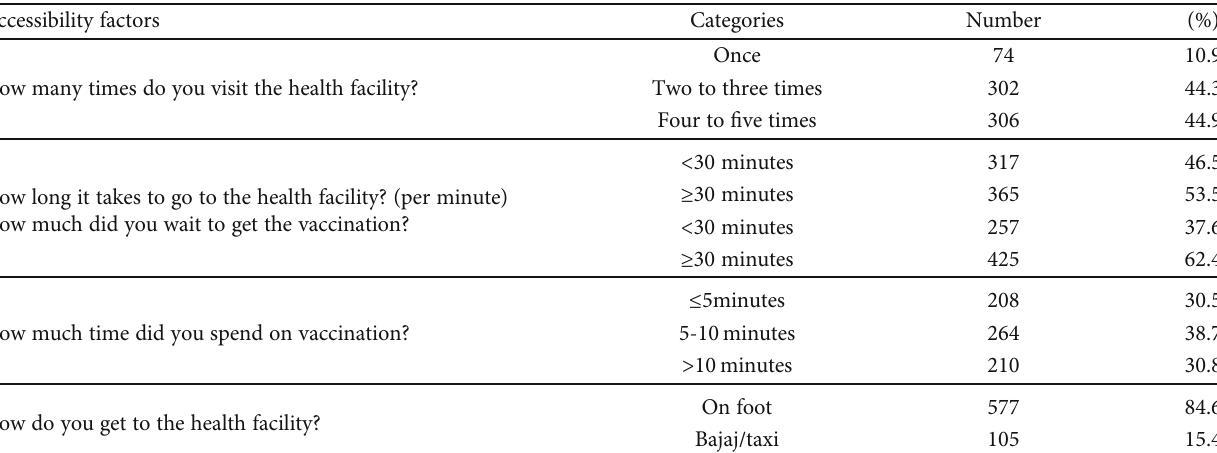
Table 2: Access-related factors for mothers whose children receiving immunization service in Wadla district, North Wollo, Amhara regional state, northeast Ethiopia,